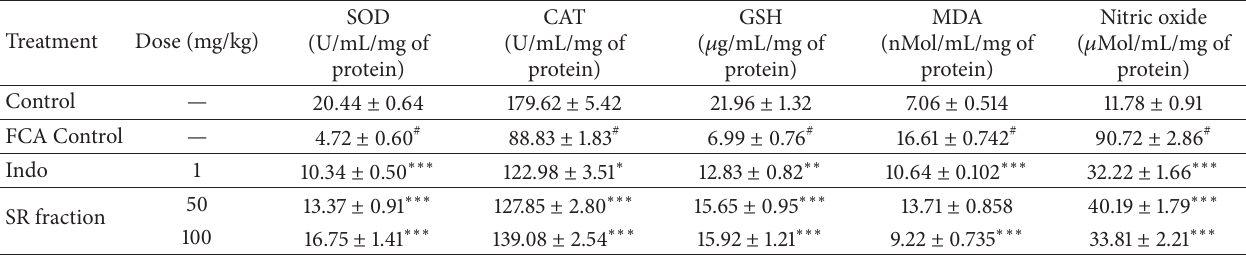
Table 4: Effect of saponin rich (SR) fraction of Achyranthes aspera on indexes of oxidative stress in liver of arthritic rats.